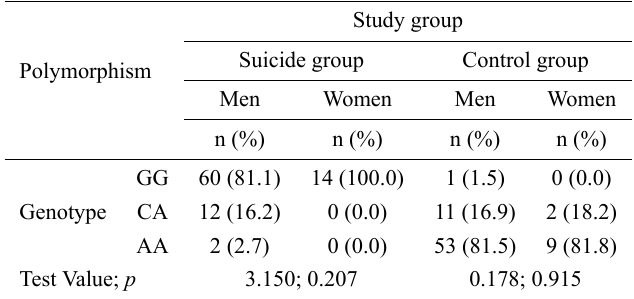
Table 10. Comparison of sex and presence of TPH-2 gene rs1386494 polymorphism in study